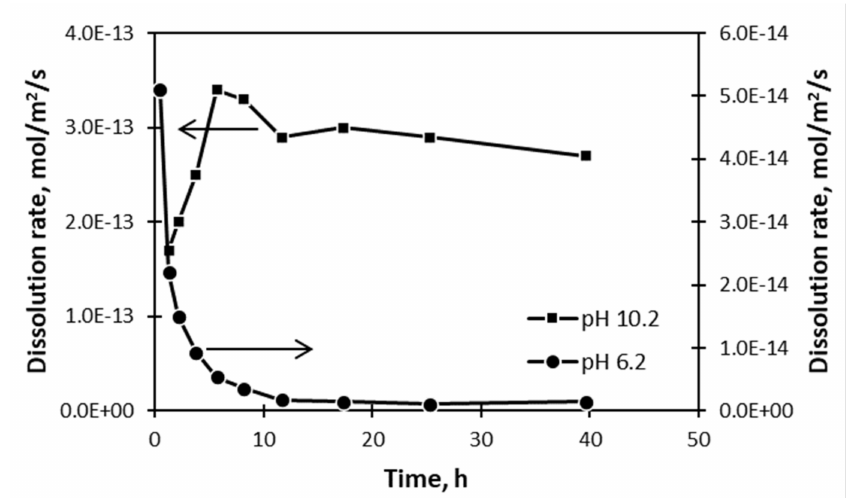
Figure 14. The change in rate of dissolution of quartz during the initial stages of the test, showing that at pH 10.2 the rate rises initially while at pH 6.2 it falls. The arrows indicate the axis to which the data refers. Data from Knauss and Wolery [12], see also Crundwell [7].